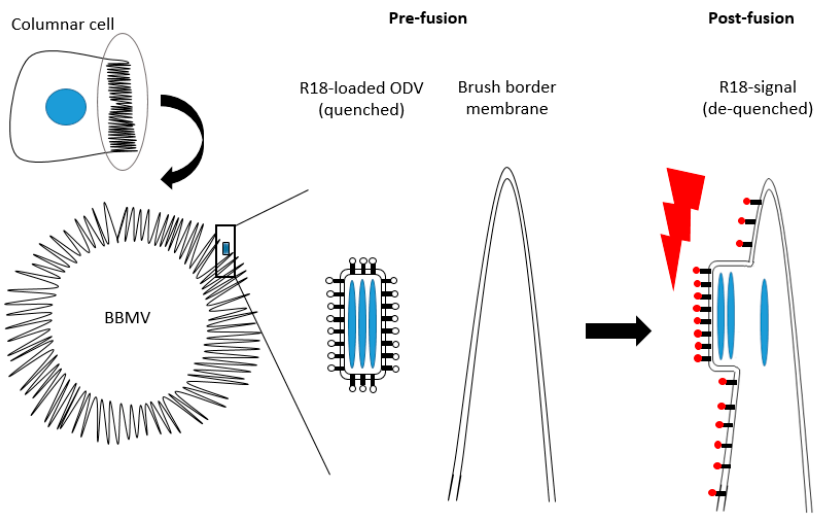
Figure 6. Schematic representation of the R18 de-quenching assay. The fluorescent activity of R18 is quenched initially in the ODV envelope because of the high concentration. Upon membrane fusion, R18 dilutes and gives a fluorescent signal.